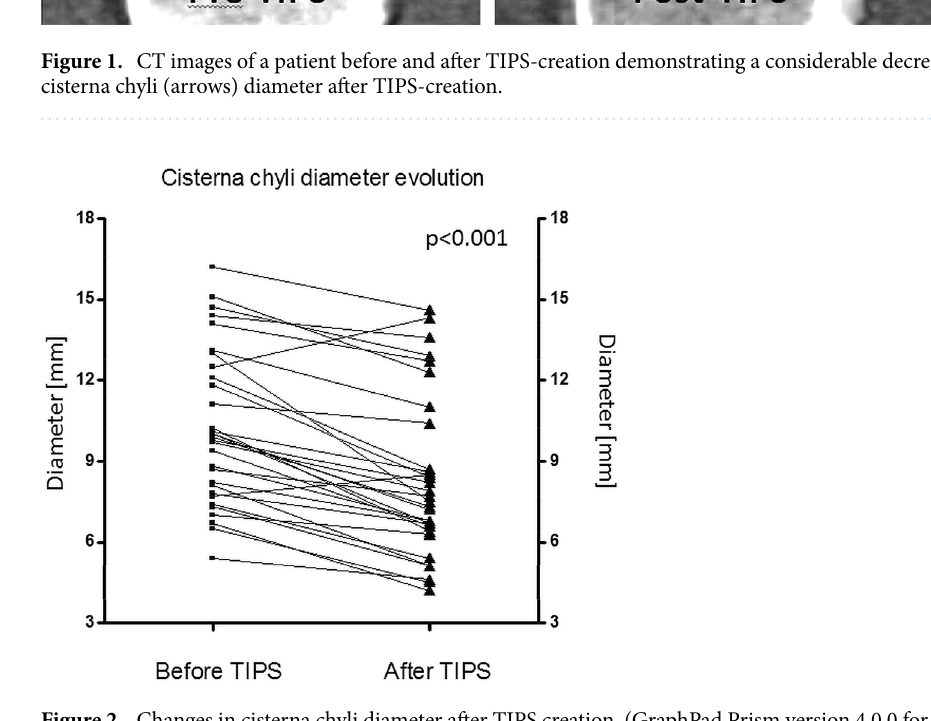
Figure 2. Changes in cisterna chyli diameter after TIPS creation. (GraphPad Prism version 4.0.0 for Windows, GraphPad Software, San Diego, California USA, www. graph pad.